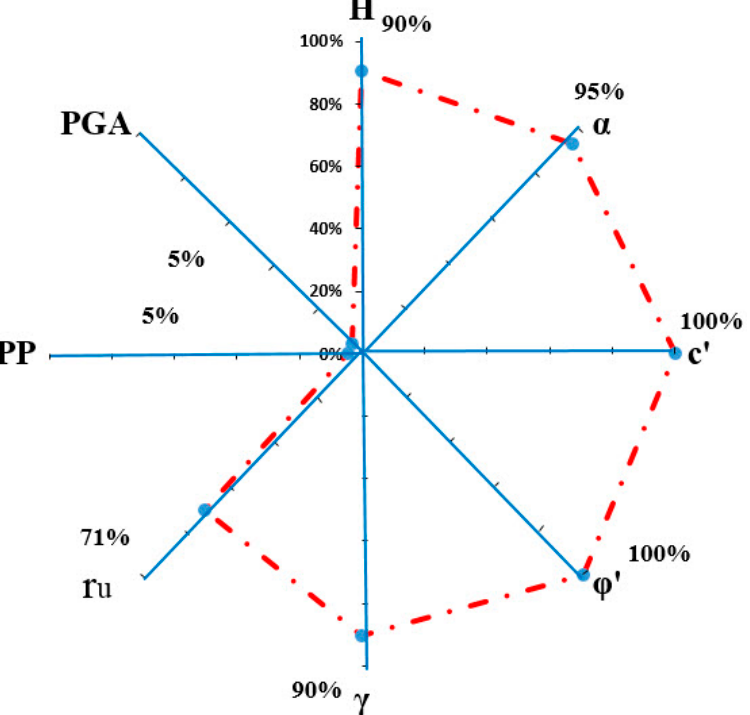
Figure 2. Frequency of geotechnical and geometrical parameters studied in the slope stability analysis research works documented in Table 1.